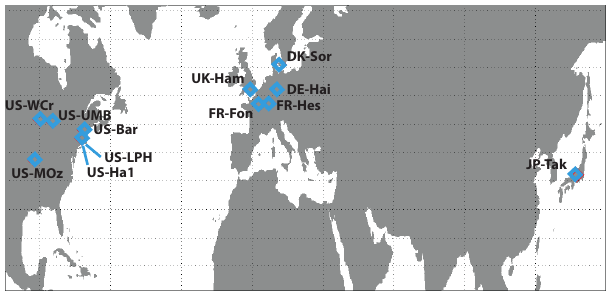
Fig. 1. Locations of the measurements